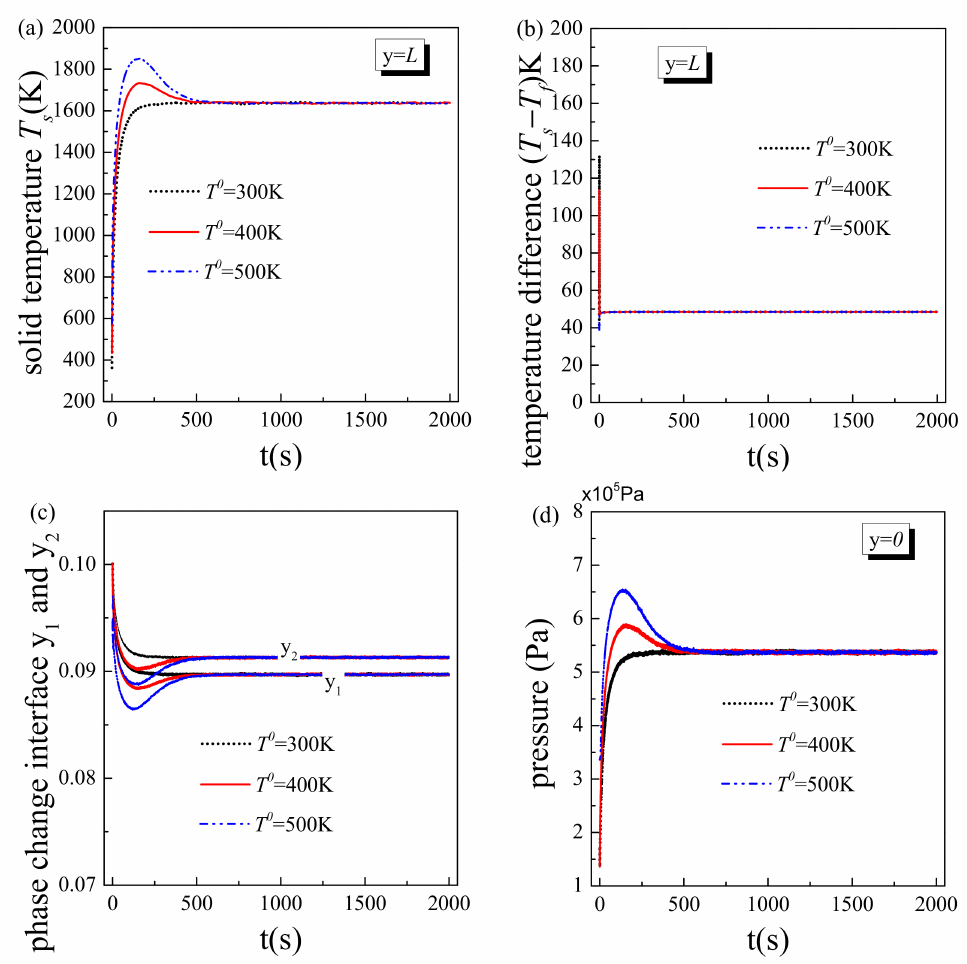
Figure 5. Transient results under different initial temperatures: ( a ) solid temperature at the hot